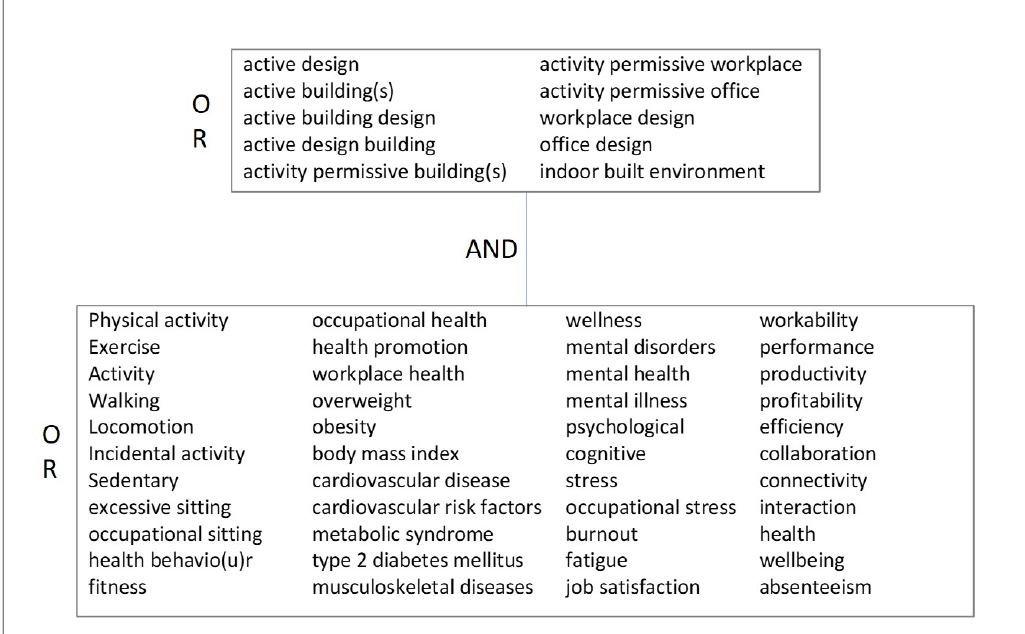
Figure 1. Search terms used in this systematic review.